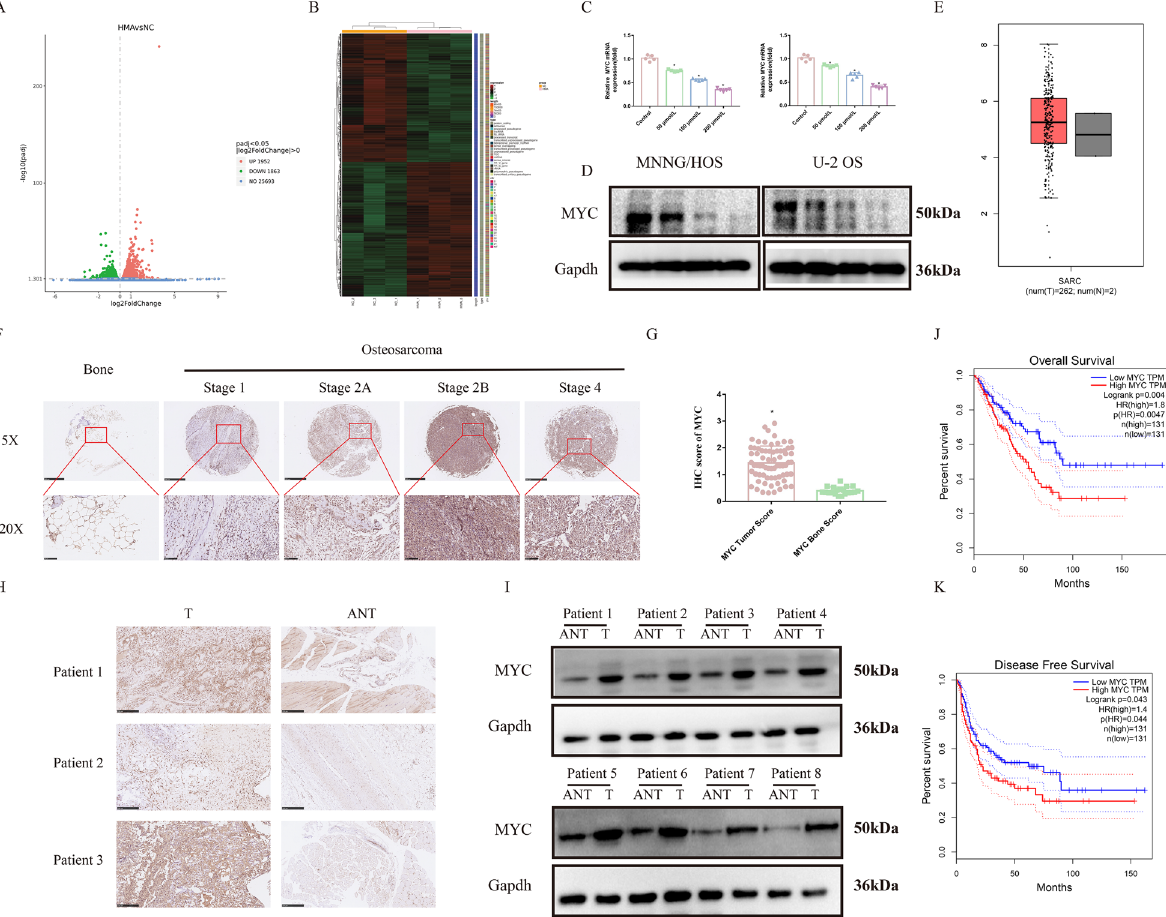
Fig. 2 High expression of MYC in osteosarcoma patients: A , B The MNNG/HOS cells were treated with 100 μmol/L of HMA. After treatment, the cells were collected and subjected to RNA-sequencing analysis. Treatment with 0, 50, 100, and 200 μmol/L of HMA was conducted to detect MYC expression level in the OS cells by C PCR and D Western blot. E mRNA of MYC in OS patients. F MYC IHC staining of the OS and bone tissues microarray and G analysis of the IHC scores. H , I IHC staining and Western blotting for MYC of the tumor and tumor-adjacent normal tissue specimens. J , K Survival curve in OS